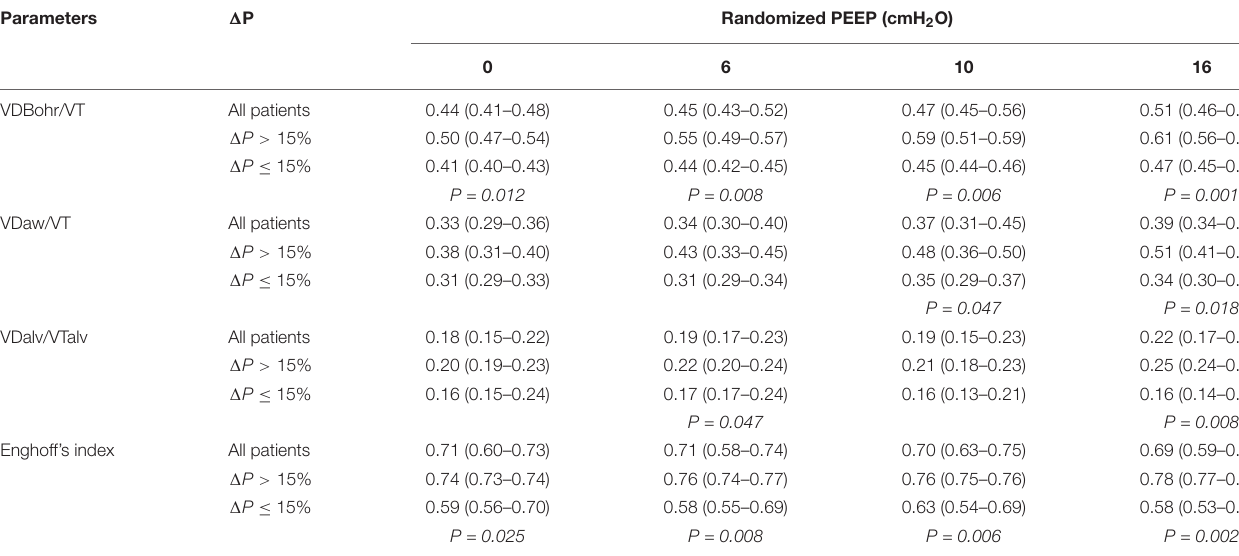
TABLE 2 | Dead space and Enghoff’s index in ARDS patients at different levels of PEEP. Parameters (cid:49)